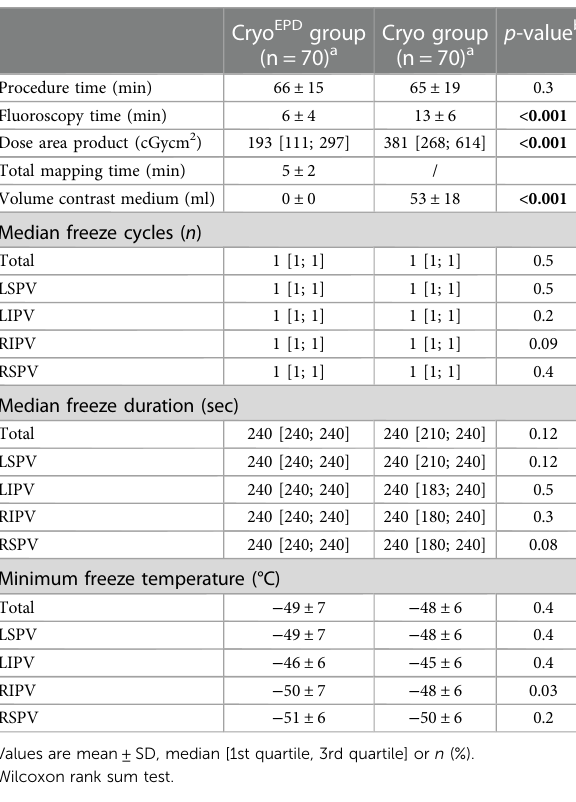
TABLE 2 Detailed procedural